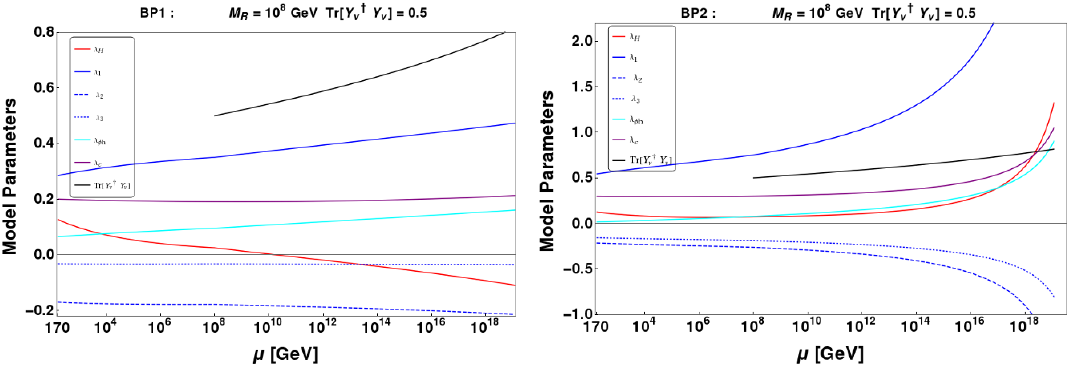
Figure 23 . Stability, metastability and instability regions plot on M R (cid:0) Tr[ Y y benchmark point BP1 (left panel) and BP2 (right panel). For illustration we have considered top mass variation in 1 (cid:27) range: 173 : 1 (cid:6) 0 : 9 GeV.